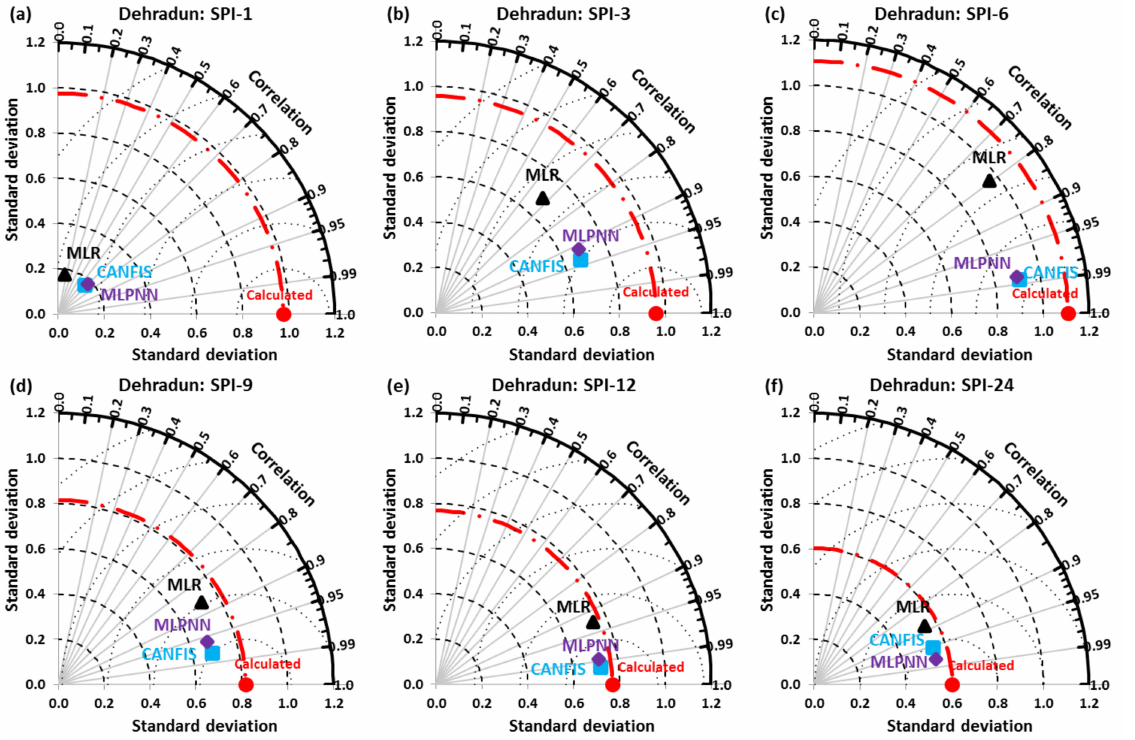
Figure 12. ( a – f ) Taylor diagram of predicted and calculated multi-scalar SPI at Dehradun